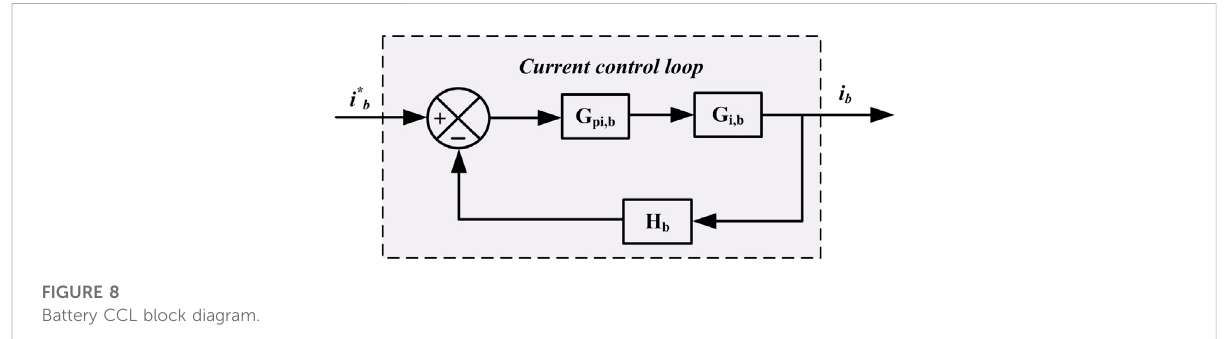
FIGURE 8 Battery CCL block diagram.